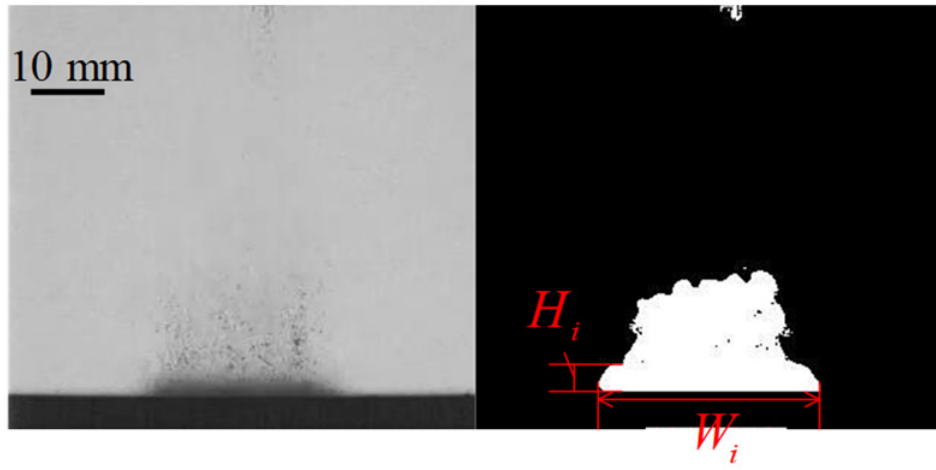
Figure 3. The impinging spray image from this procedure and impinging spray height and width were were defined.